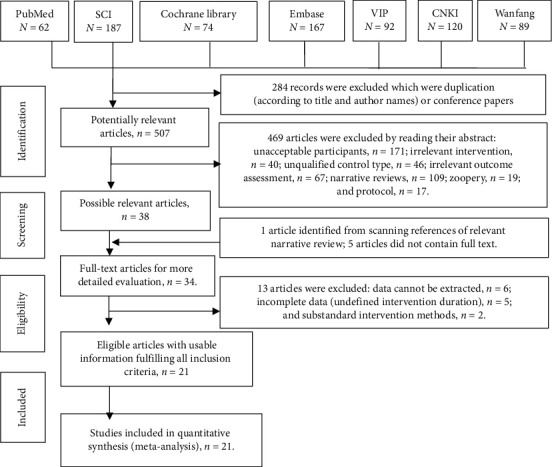
Details of literature search and selection. SCI: Science Citation Index; VIP: Chinese Scientific Journal Database; CNKI: China National Knowledge Information database.